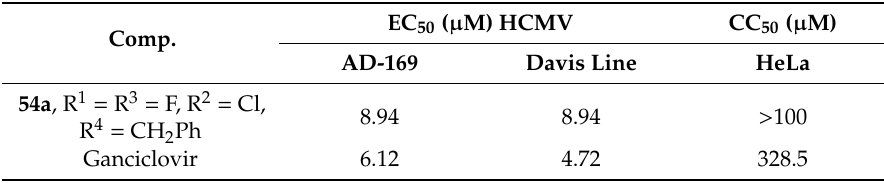
Table 23. The antiviral activity of the 3-deazapurine derivative 54a . Comp.